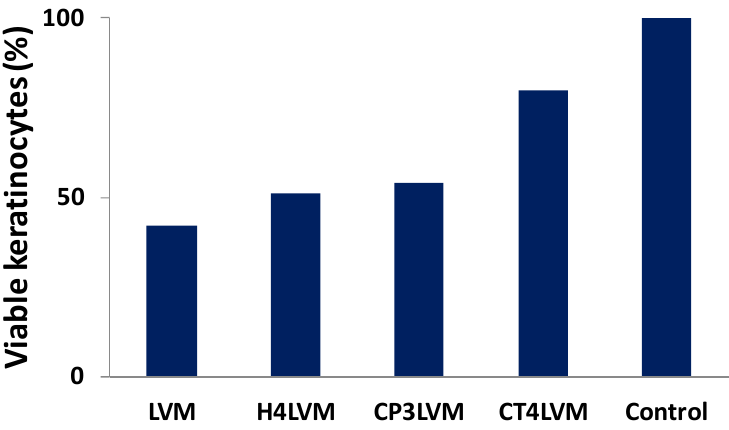
Figure 9. Percentage of viable keratinocytes for LVM microemulsion and gel microemulsions.